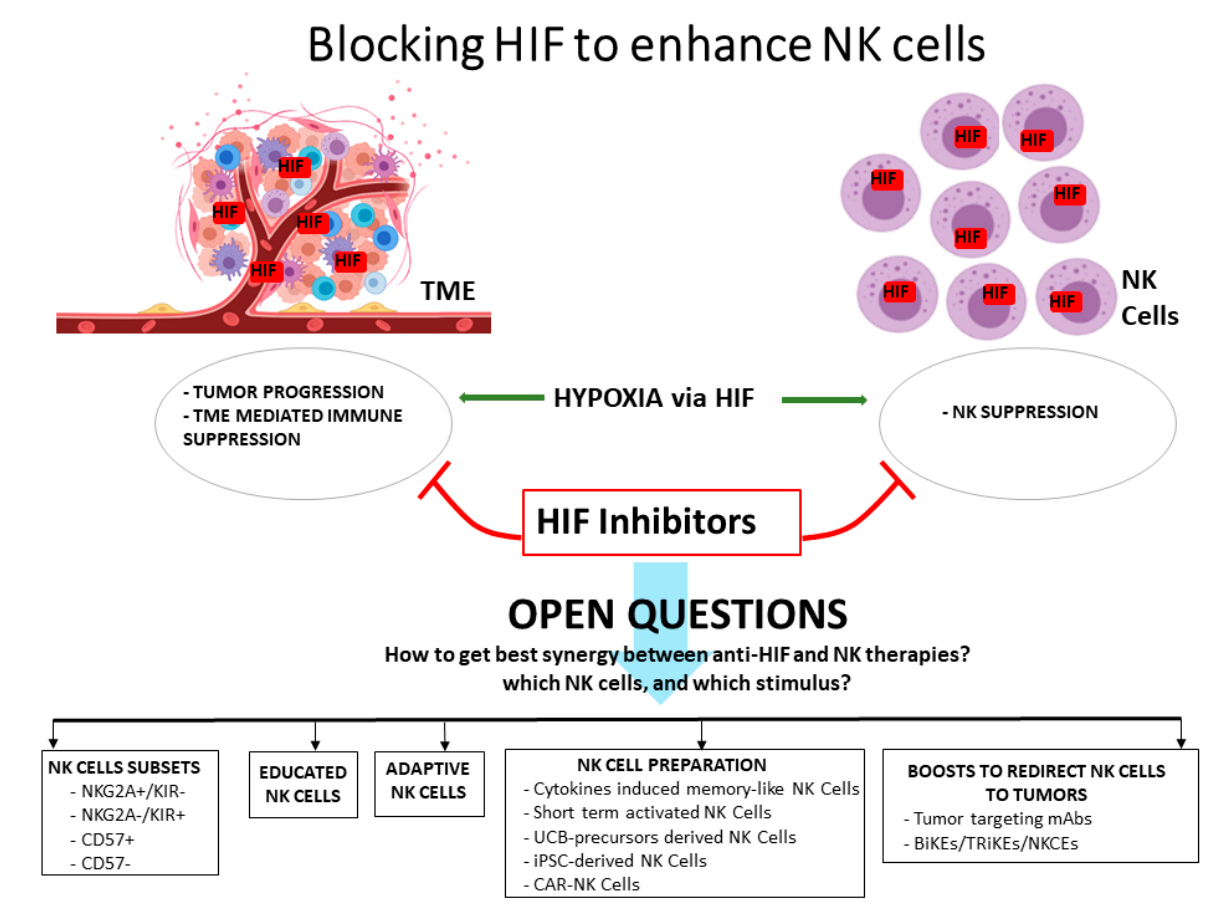
Figure 1. Blocking HIF to enhance NK cells.